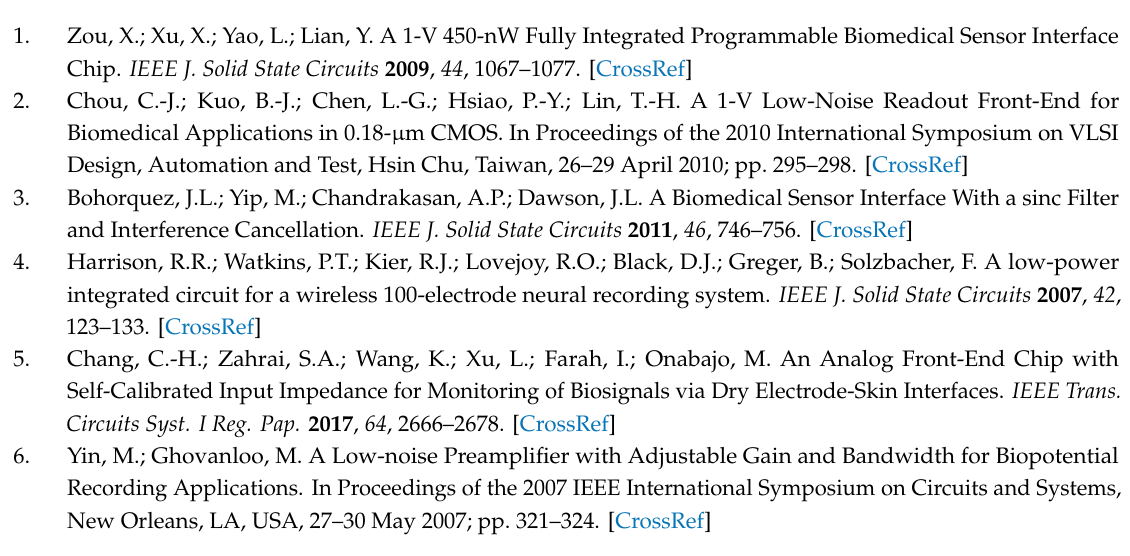
Figure A2. Corner simulations of the amplifier of Figure 3 at the symmetrical input drive: ( a ) for 5-nA I BIAS ; ( b ) for 50-nA I BIAS . V DD is 1 V.